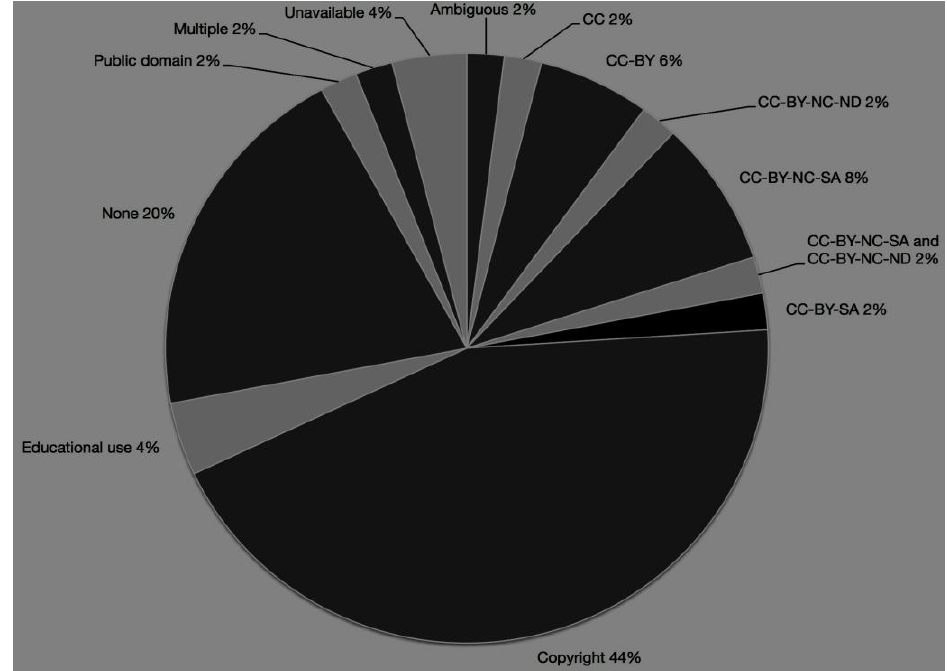
Figure 4. Licenses portrayed on main site or dedicated